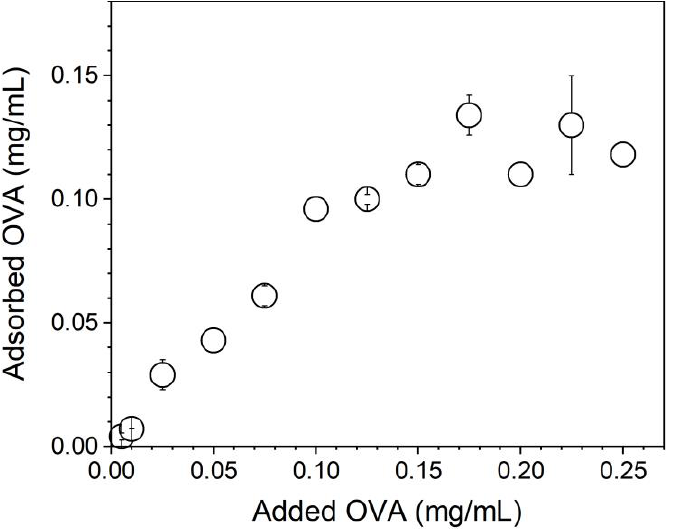
Figure 5. OVA adsorption isotherm onto PMMA/DODAB/PDDA NPs in Milli-Q water.